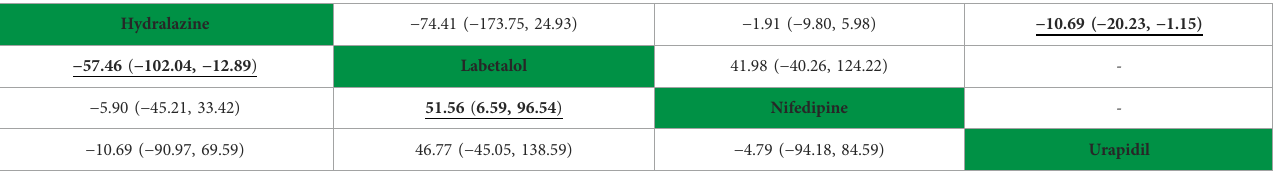
TABLE 4 Network comparison and direct comparison results for dosage required to achieve target blood pressure (mg).